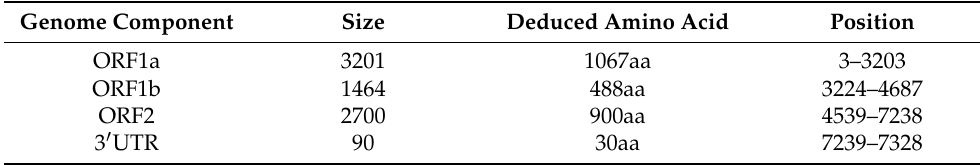
Table 1. Genome composition of the isolated strain.